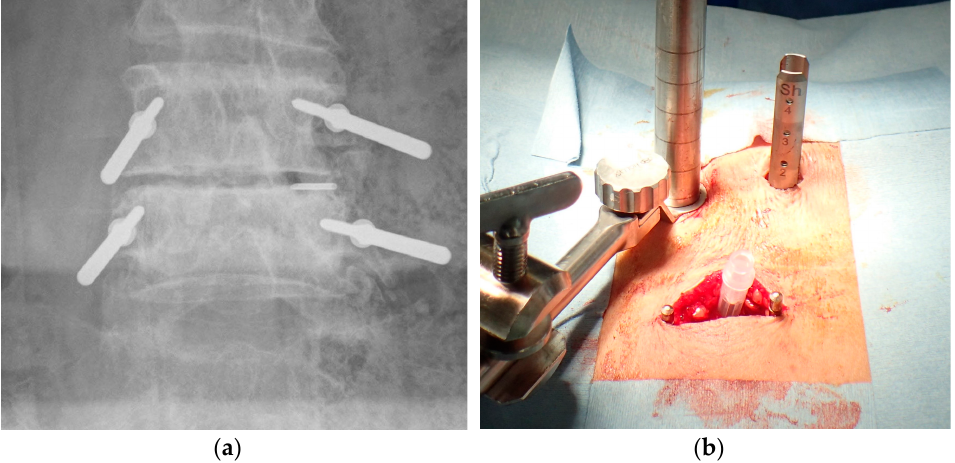
Figure 5. ( a ) Posteroanterior radiograph showing direction of self-drilling pins; ( b ) Pedicle screw insertion into the opposite side of the laminectomy via the tubular retractor.